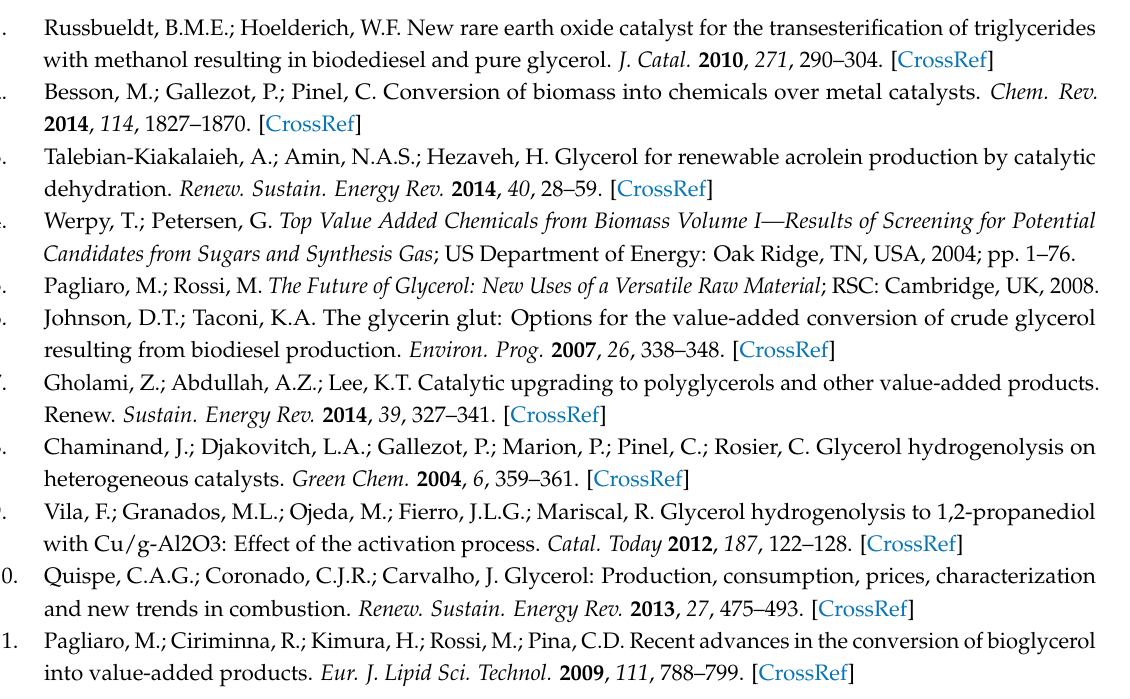
Table S1: Propan-2-ol conversion and products distribution obtained in the gas-phase propan-2-ol transformation test reaction at 200 ◦ C (time on stream, 2 h). Sel. Acid: selectivity to products formed on acid sites (propene and diisopropyl ether); Sel. Basic or Redox: selectivity to products formed on basic or redox sites (acetone and diacetone